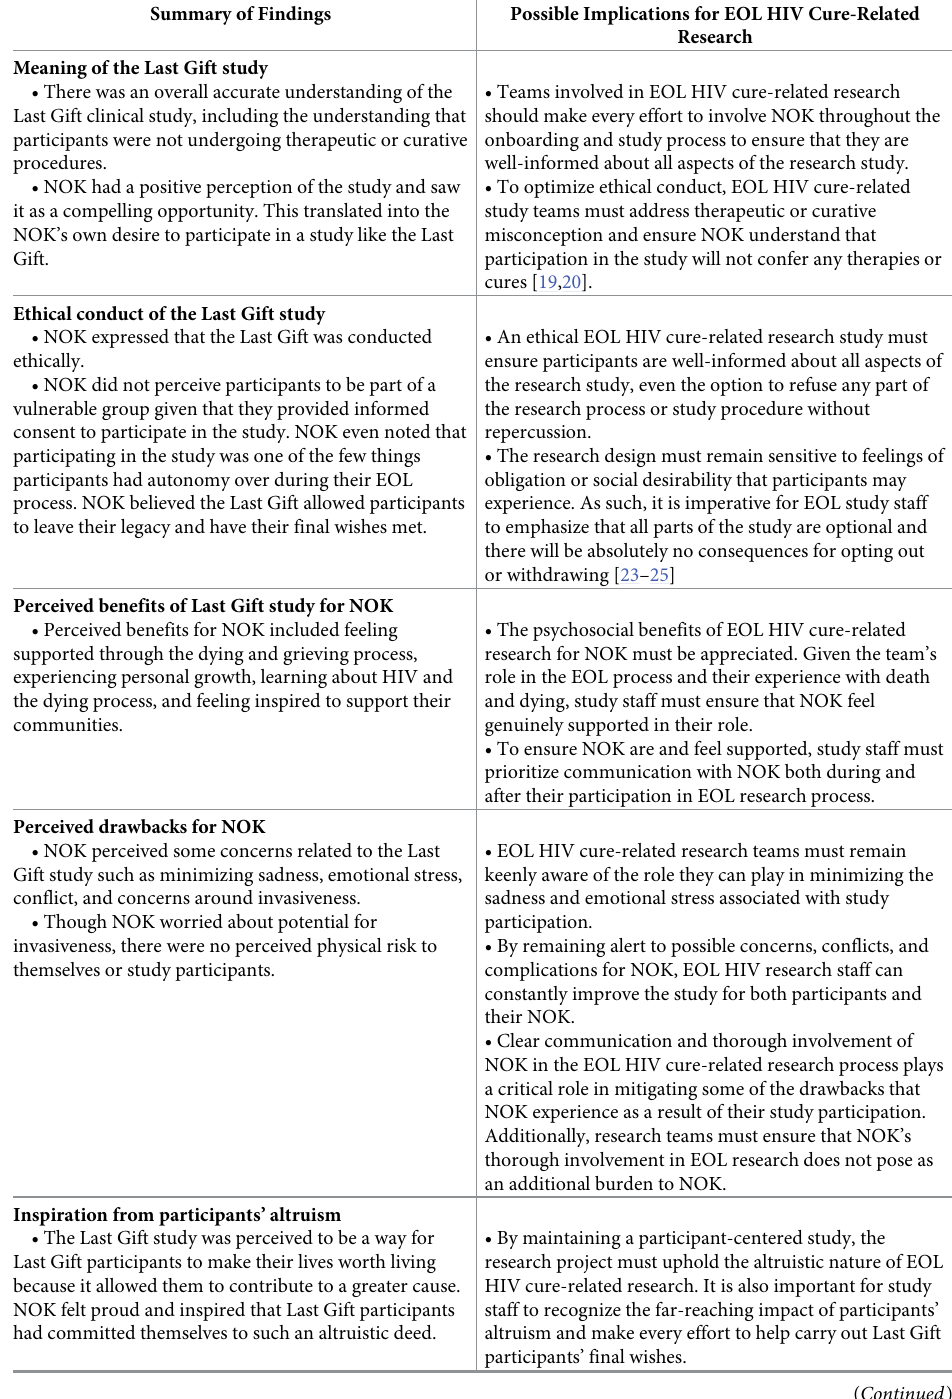
Table 4. Summary of findings and possible implications for future EOL HIV cure-related research studies involv- ing NOK/loved ones (San Diego, California,